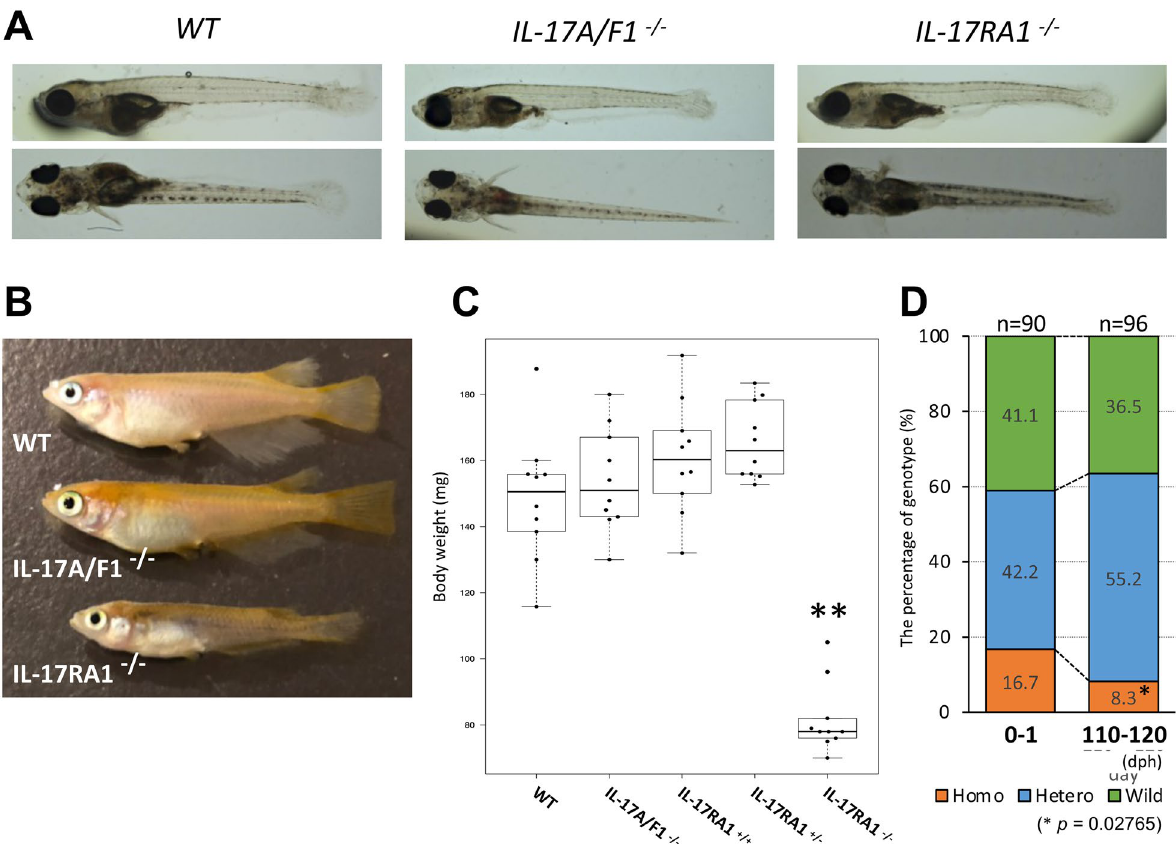
Figure 2. IL-17RA1-knockout (KO) medaka showed significant weight loss compared with WT and IL-17A/ F1-KO medaka. ( A–C ) Comparison of medaka larvae at 0–1 day post-hatching (dph). No apparent differences were observed among WT, IL-17A/F1-KO, and IL-17RA1-KO medaka larvae at 0–1 dph ( A ), but severe weight loss was seen at 110–120 dph in IL-17RA1-KO medaka ( B ). Body weights were significantly lower only in homozygous IL-17RA1-KO medaka, compared to those of WT medaka, medaka with homozygous IL-17A/ F1 mutants, and medaka with other genotypes. Different letters abovethe bars indicate significant difference at P < 0.05 as indicated by Tukey–Kramer multiple comparison tests in R (version 3.5.3) after one-way ANOVA. The data shown were obtained in one experiment with ten individual fish (n = 10). ( D ) The proportion of homozygous IL-17RA1-KO medaka decreased significantly at 110–120 dph. The exact binomial test was used for statistical analysis in R (version down-regulated genes: 123). In the posterior intestine, 205 genes were identified as DEGs (up-regulated genes: 124, down-regulated genes: 81), as shown in Fig. 7A. Of these DEGs, genes down-regulated or up-regulated by threefold are shown in Tables S4–S7. We detected 24 DEGs commonly down-regulated in both the anterior and posterior intestines of IL-17RA1-KO, as well as 35 DEGs commonly up-regulated in both intestinal regions (Fig. 7B). We further visualized interactions between DEGs using the String App in Cytoscape. We examined potential relationships between IL-17RA and the DEGs by adding IL-17RA to the analysis and localized many metabolism-related genes; 47 genes clustered together with IL-17RA among the 123 down-regulated DEGs. Interestingly, IL-17C (an IL-17RA ligand) and the Th17 master transcription factor, nuclear receptor ROR-alpha ( rorc ), were included in this relationship. Furthermore, 10 genes including mevalonate pathway-related genes, mevalonate diphosphate decarboxylase ( mvda ), acetyl-CoA acetyltransferase 2 ( acat2 ), 3-hydroxy-3-methyl- glutaryl-CoA synthase 1 ( hmgcs1 ), and 3-hydroxy-3-methylglutaryl-coenzyme A ( hmgcr ) showed particularly strong interactions (Fig. 8). These 47 genes are presented in Table 1. Of the DEGs with increased expression in the anterior intestine, 102 genes formed a cluster containing IL-17RA. In particular, a series of collagen genes showed strong interactions (Fig. S6). Furthermore, among the DEGs that were significantly decreased in the posterior intestine, some were possibly related to IL-17RA1, including IL-17A/F1, growth arrest and DNA damage inducible alpha ( gadd45a ), chymotrypsin-like elastase family member 2A ( ela2 ), neuraminidase 1 ( neu1 ), and signal transducer and activator of transcription 3 ( stat3 ) (Fig. S7A). However, we did not find a gene cluster among the elevated DEGs that interacted with IL-17RA (Fig. S7B). Furthermore, GO analyses were performed on the DEGs using the DAVID program. Among the down- regulated DEGs in the anterior intestine of IL-17RA1-KO medaka, terms related to various metabolic process including lipid metabolism, steroid metabolism, lipid biosynthesis, and oxidation reduction were annotated in